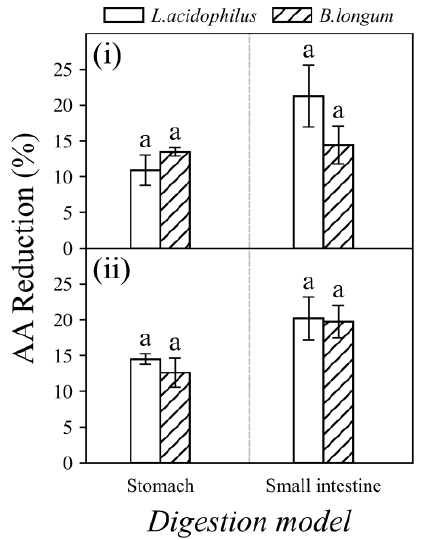
Figure 6. Acrylamide (AA) reduction percentages of L. acidophilus and B. longum (10 9 CFU/mL) in spiked food samples (7500 ng AA/g food): ( i ) biscuits and ( ii ) chips after in vitro digestion in stomach and intestinal compartments. Incubated at 37 °C for 4 h. Different characters in each panel indicate significant differences, whereas same character indicates no significant difference.